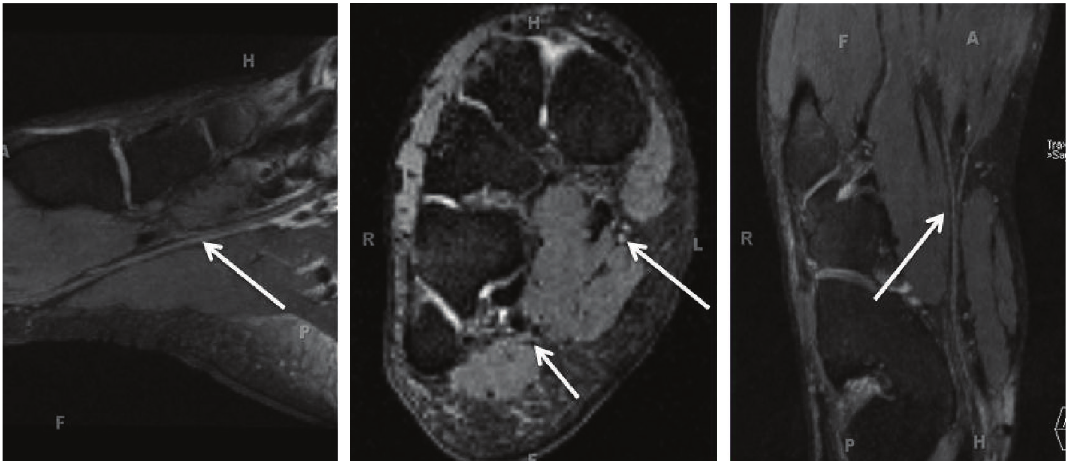
Figure 4: 3D anatomic nerve selective MRN-Multiplanar reconstructions from an isotropic 3D DW PSIF sequence through the mid foot shows the normal long axis appearances of the medial plantar nerve (large arrows) and lateral plantar nerve (small